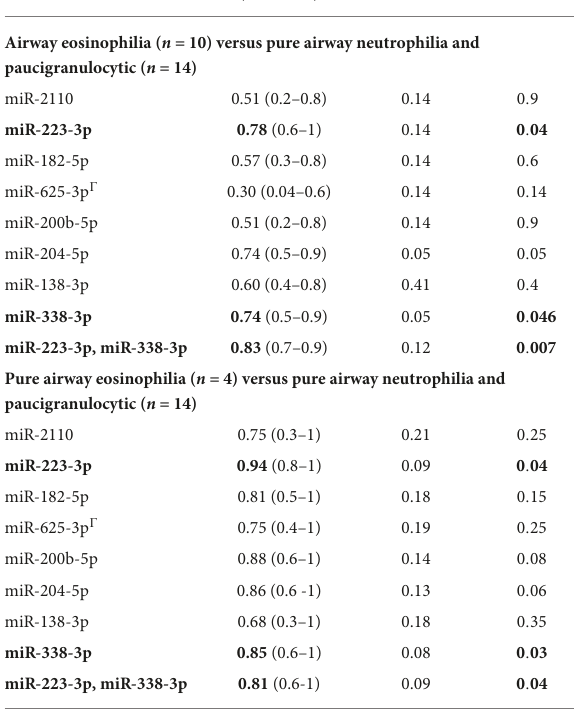
TABLE 3 Receiver operative characteristic (ROC) analyses to determine predictive ability of miRNA to differentiate between eosinophilic and non-eosinophilic subtypes in chronic obstructive pulmonary disease (COPD). P miRNA AUC Standard (95% CI) Error a